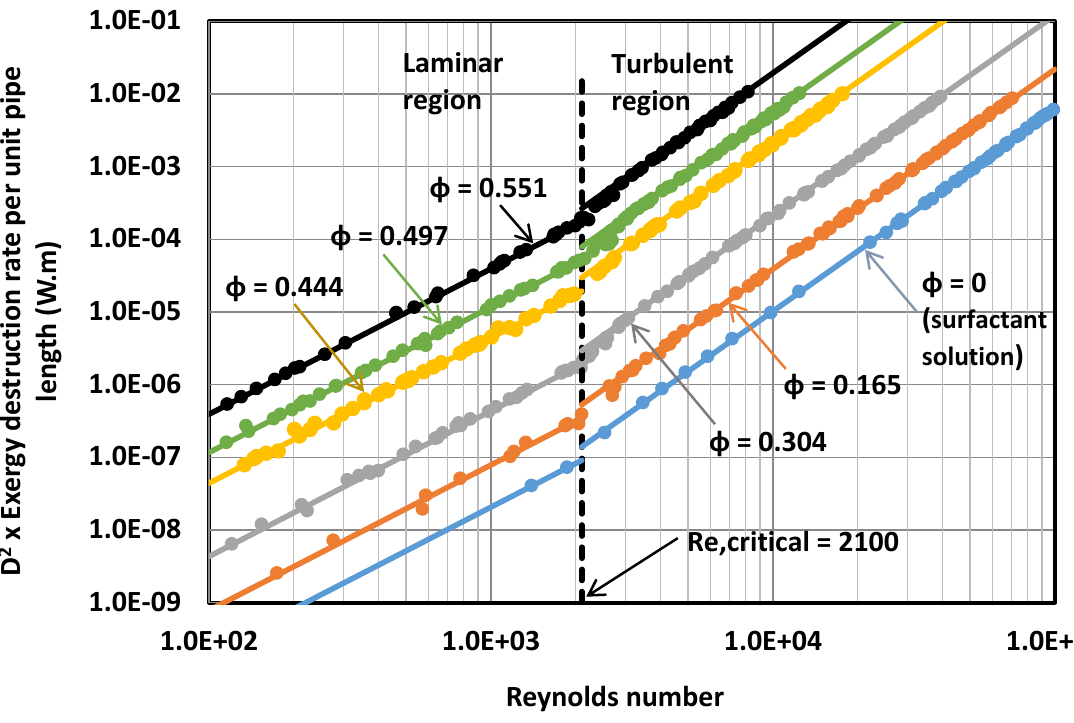
  versus Re plots for surfactant-stabilized O/W emulsions with different Figure 13. 2 D D volume fractions of